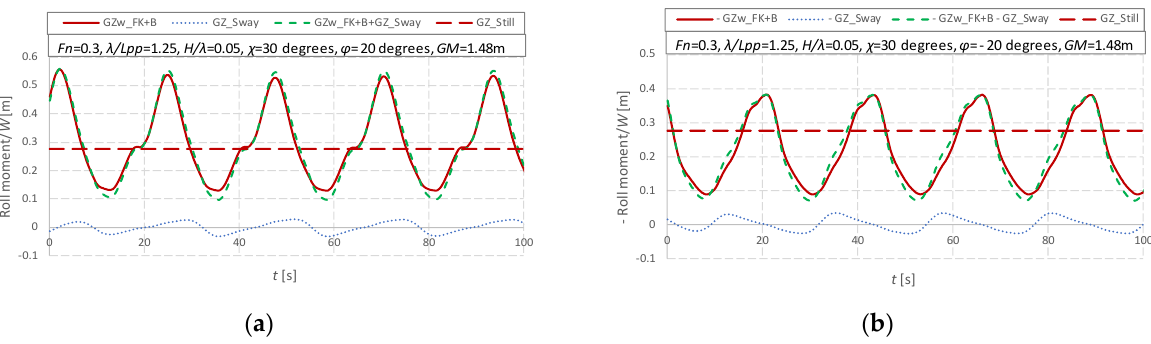
direction with φ = 20, −2 0 degrees, ( a ) starboard; ( b ) port. direction with ϕ = 20, − 20 degrees, ( a ) starboard; ( b )